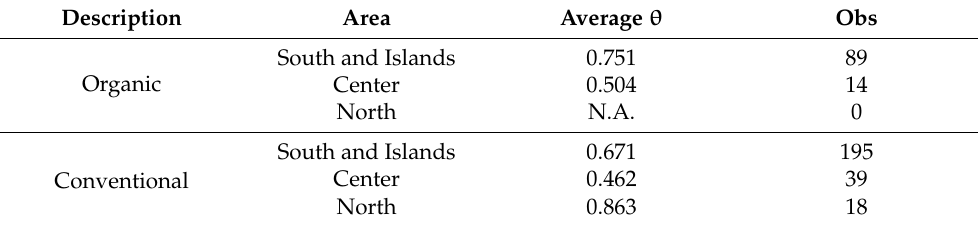
Figure 1. Technical efficiency parameter ( θ ). Table 4. Descriptive statistics and average values of technical efficiency (TE) by macro areas.